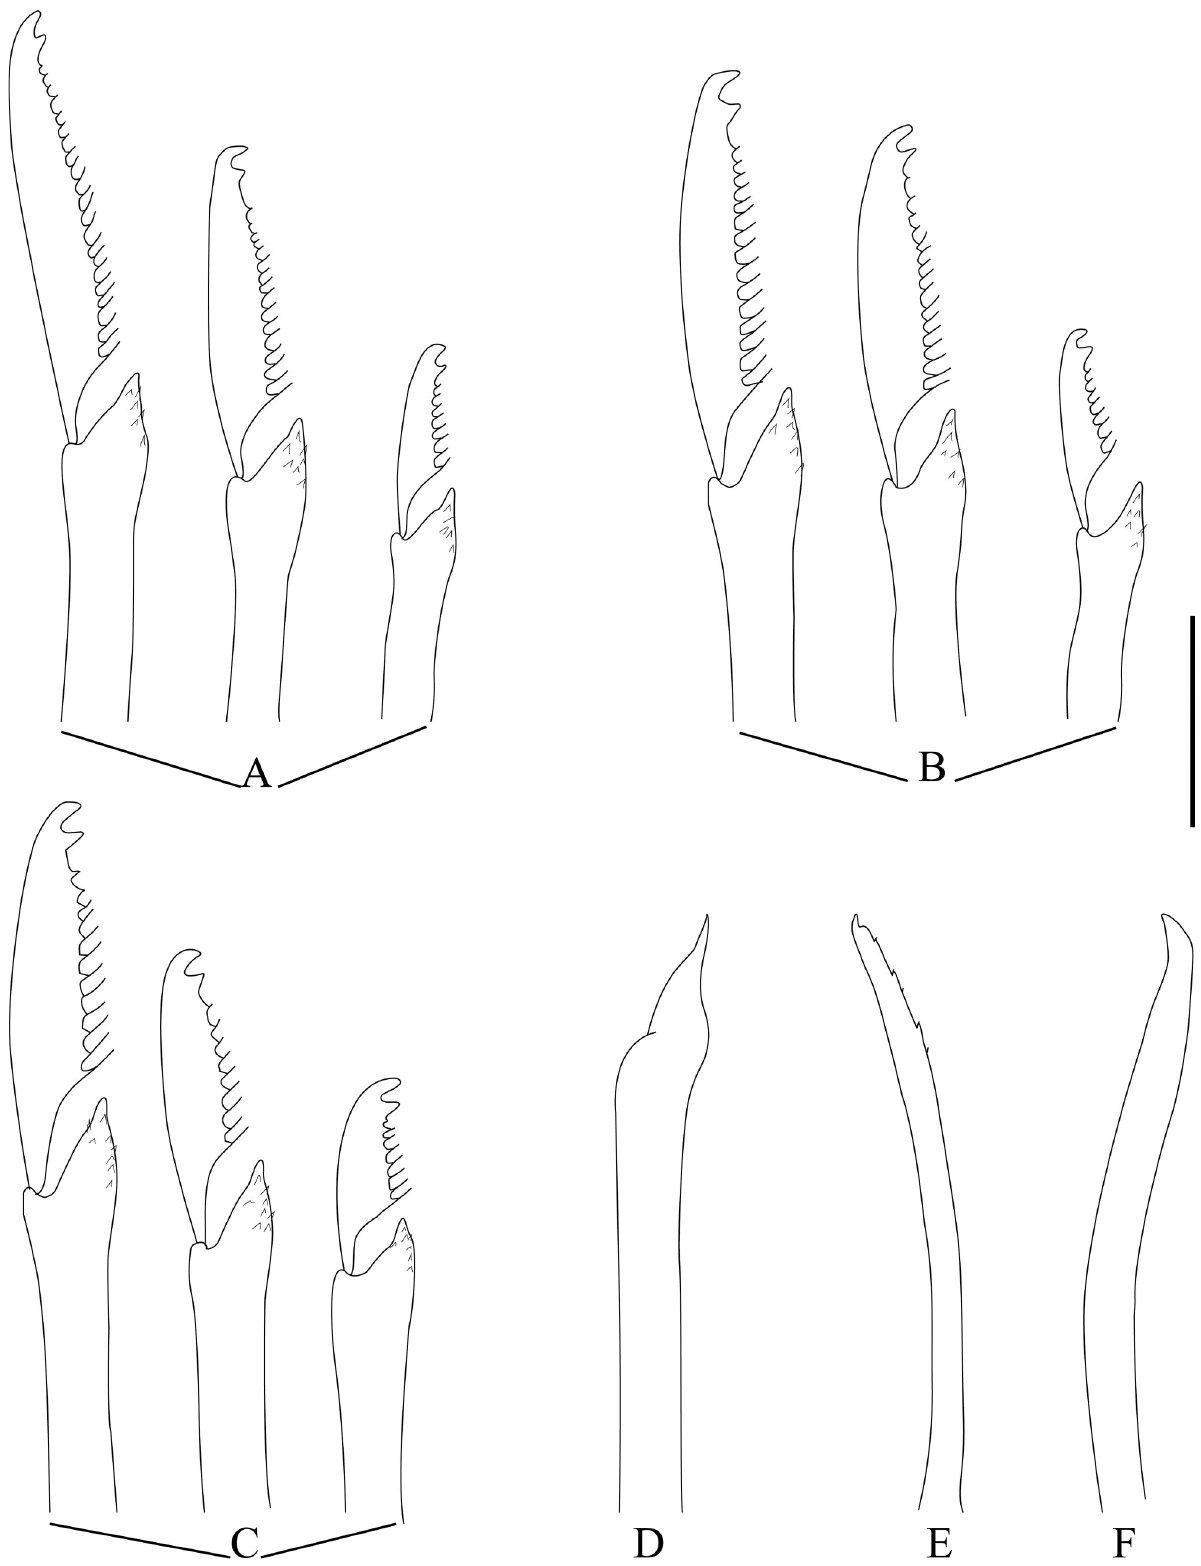
Fig 15. Salvatoria sp. (A–C). Falcigers, anterior, mid- and posterior body, respectively; (D). Acicula, posterior body; (E). Dorsal simple chaeta, midbody; (F). Ventral simple chaeta, posterior body. Scale bar: A–F, 7 μ m. https://doi.org/10.1371/journal.pone.0250472.g015 PLOS ONE | https://doi.org/10.1371/journal.pone.0250472 May 5,